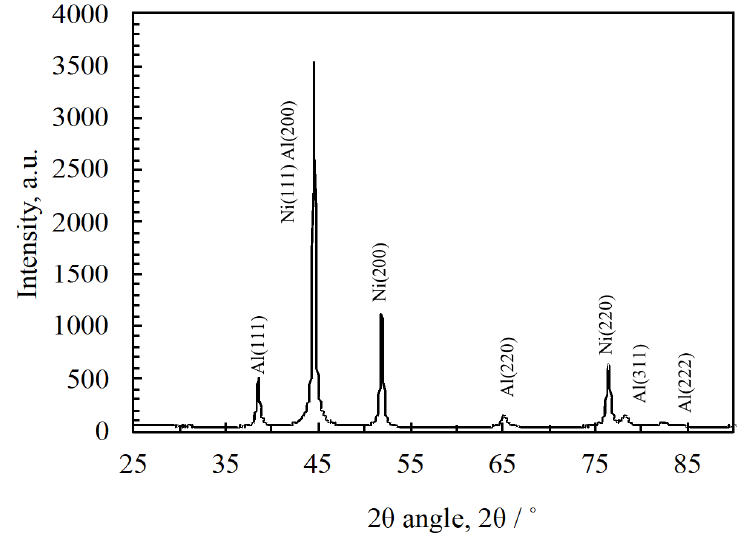
Figure 4. Result of the x-ray diffraction (XRD) measurement of the cold-rolled Al/Ni multilayer powder (before the reaction).